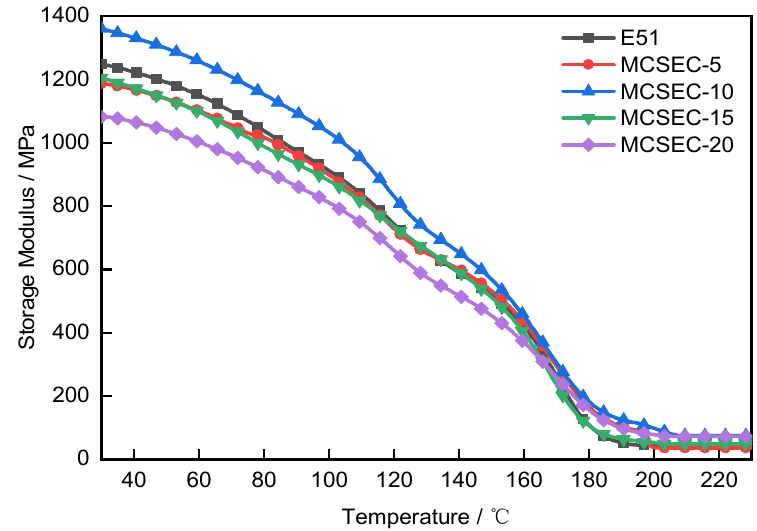
Figure 4. Storage modulus of KHCS/E-51 composites with different contents.